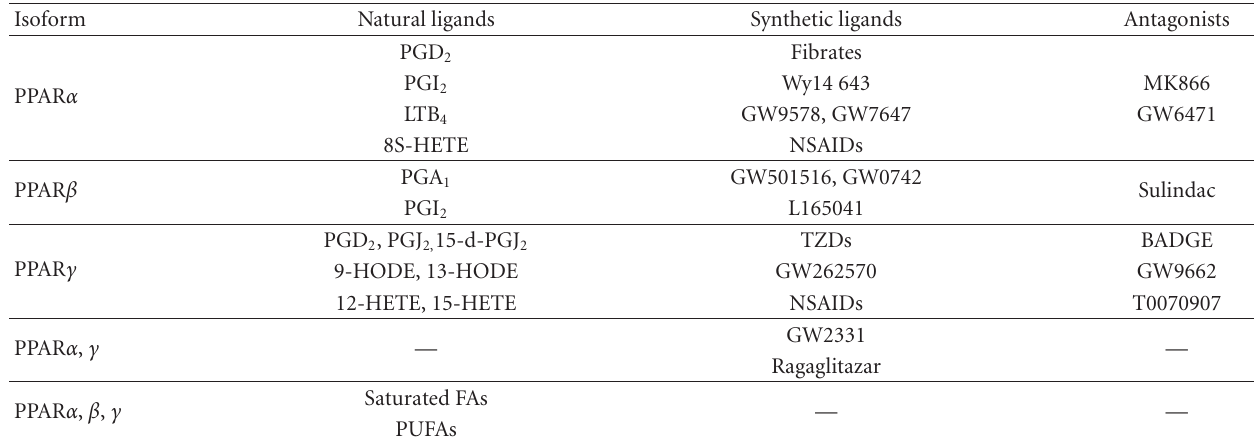
Table 1: Natural and synthetic ligands for PPAR